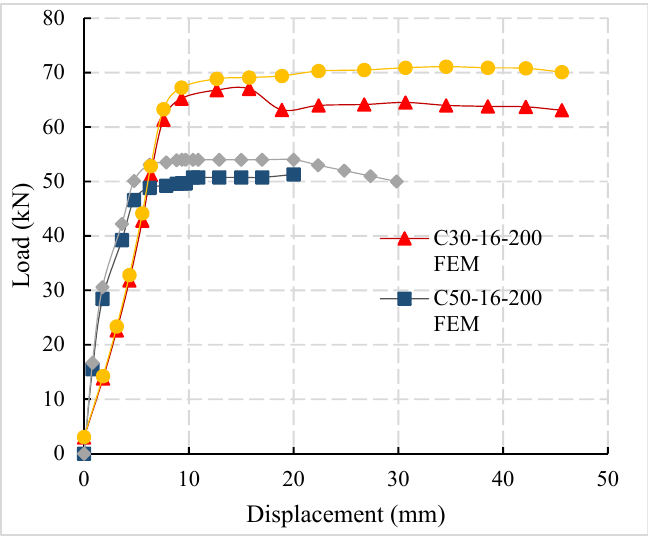
Figure 11. Comparison of load-displacement curves.